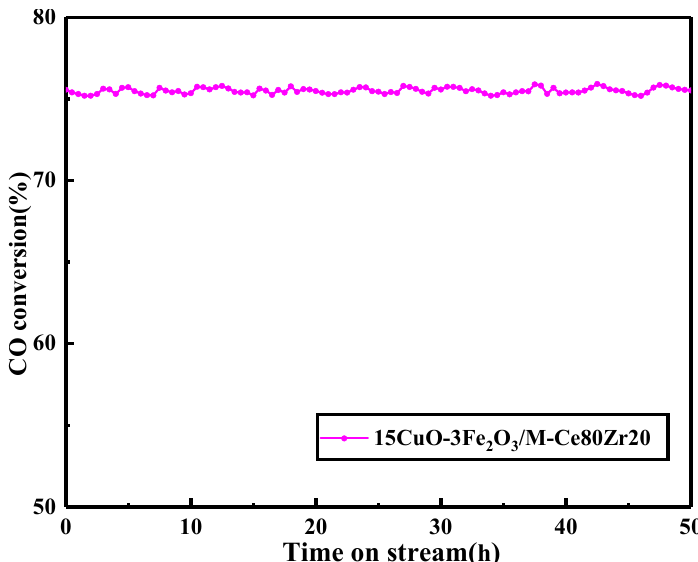
Figure 11. Long-term stability test over the 15CuO-3Fe 2 O 3 / M-Ce80Zr20 catalyst; reaction conditions: 1%CO-20%O 2 -N 2 balance, GHSV = 12000 mL/(g·h), 70 ° C, 1 atm.